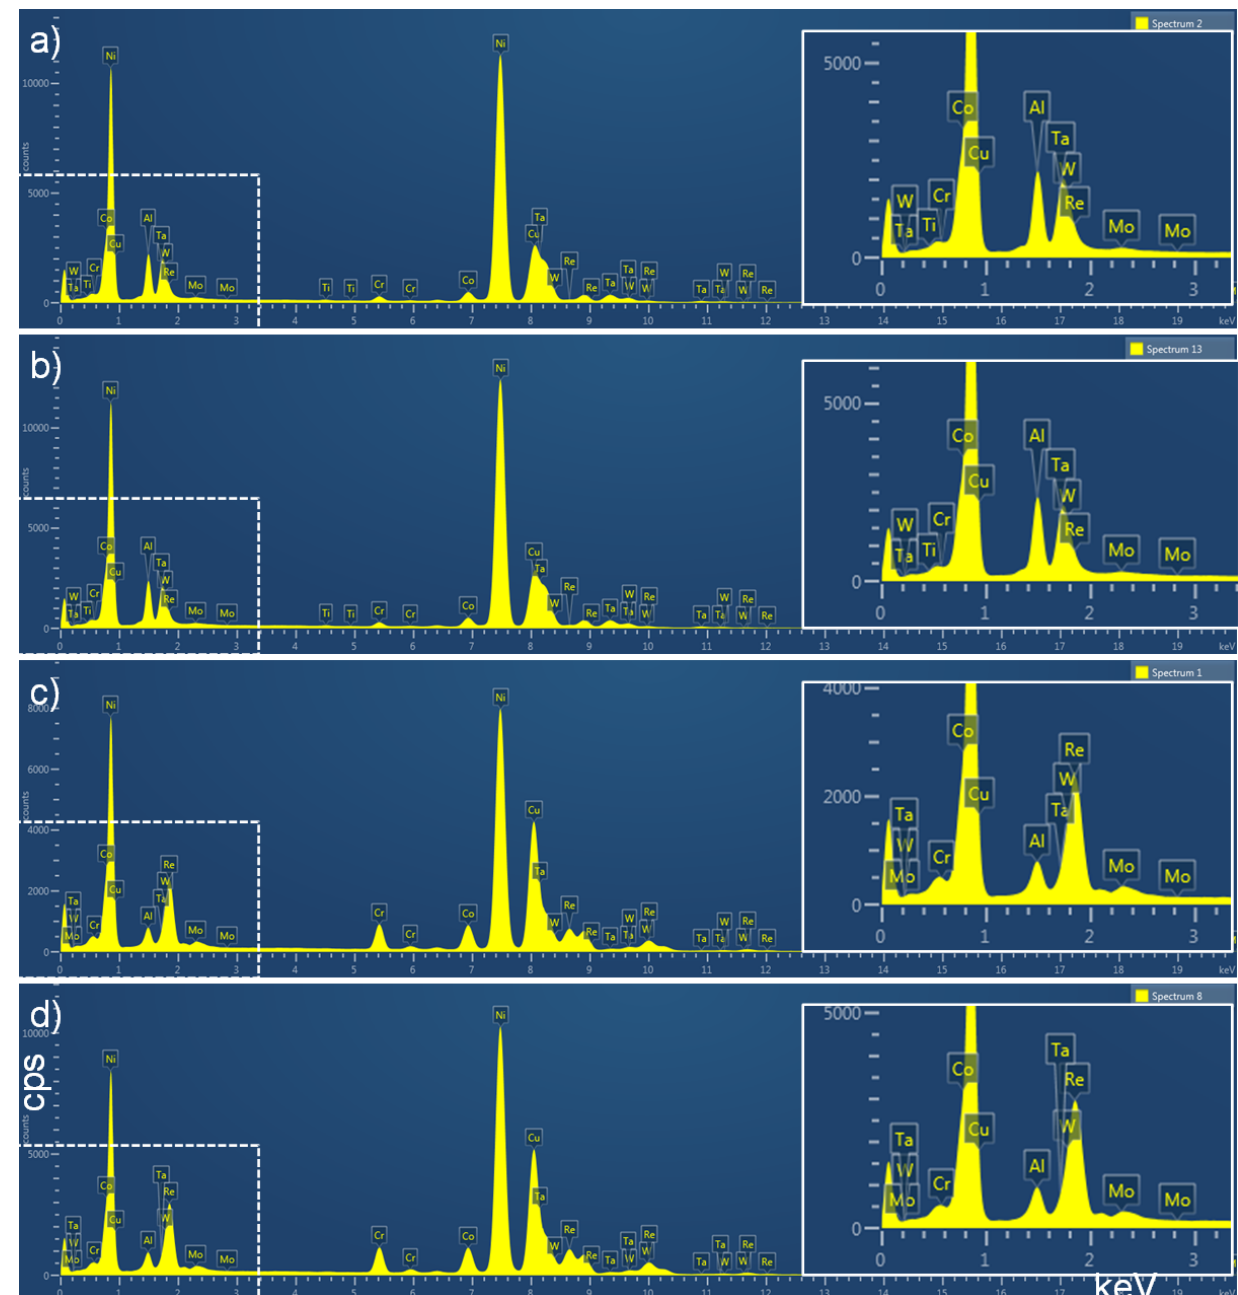
Figure 4. STEM ‐ EDX spectra acquired at the dendrite core ( a , c ) and the interdendritic region ( b , d ): ( a , b ) gamma prime phase, and ( c , d ) gamma phase. The inserts are enlarged spectra from the marked range, respectively.